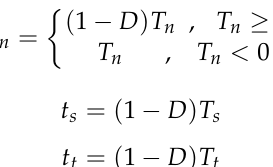
Figure 3. Permeable layer of the fracture surface.